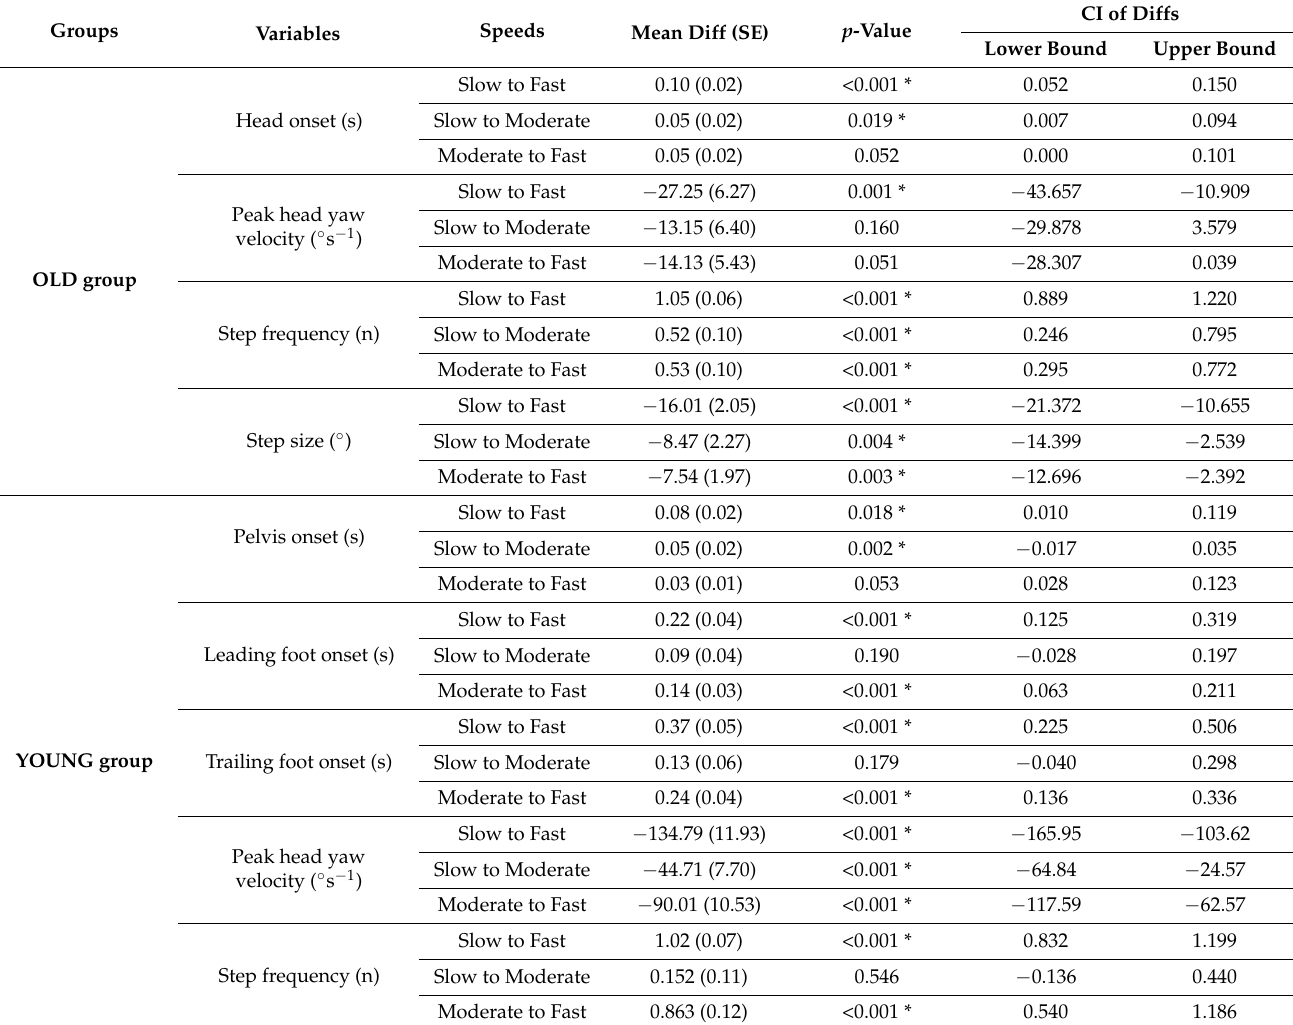
Table 3. Post hoc comparisons RM ANOVA revealed the effects of turning speed in each group.